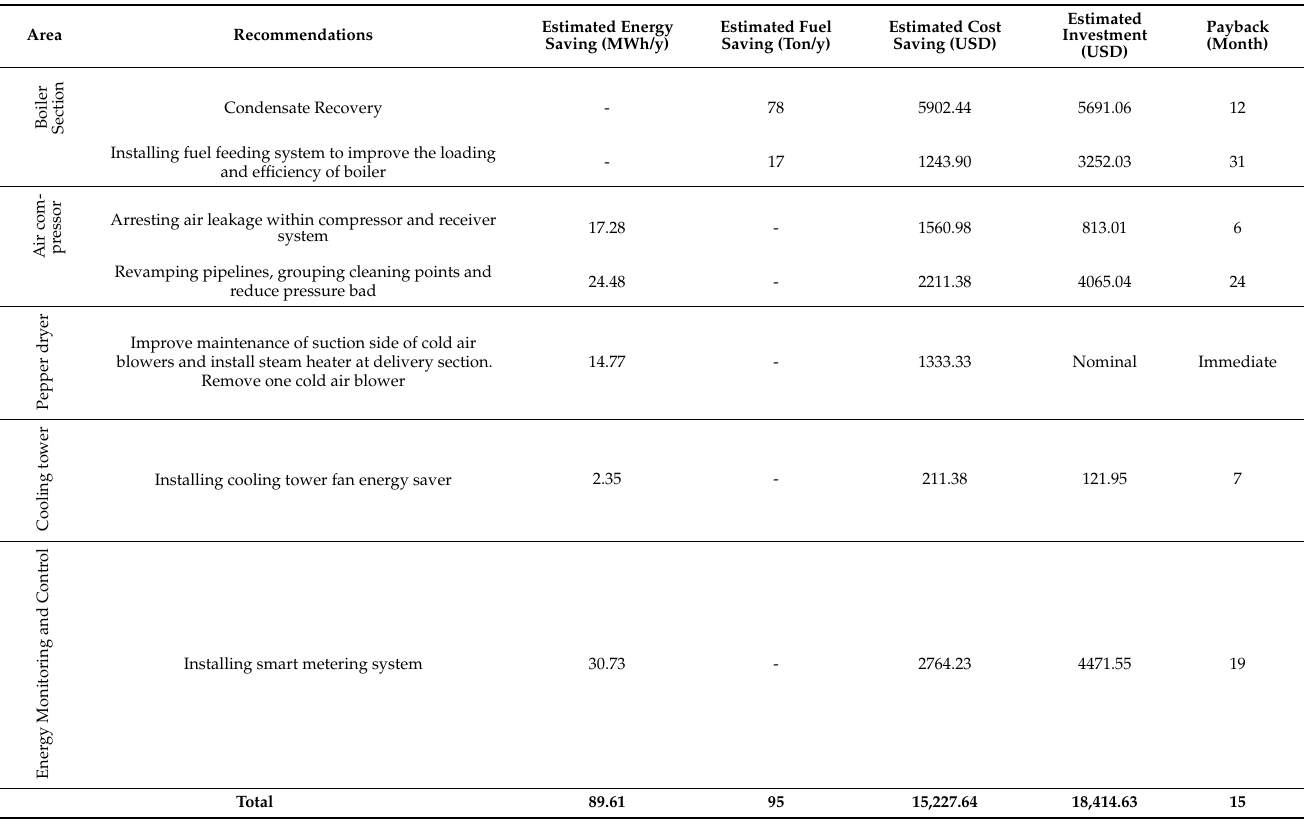
Table 16. List of energy saving options with